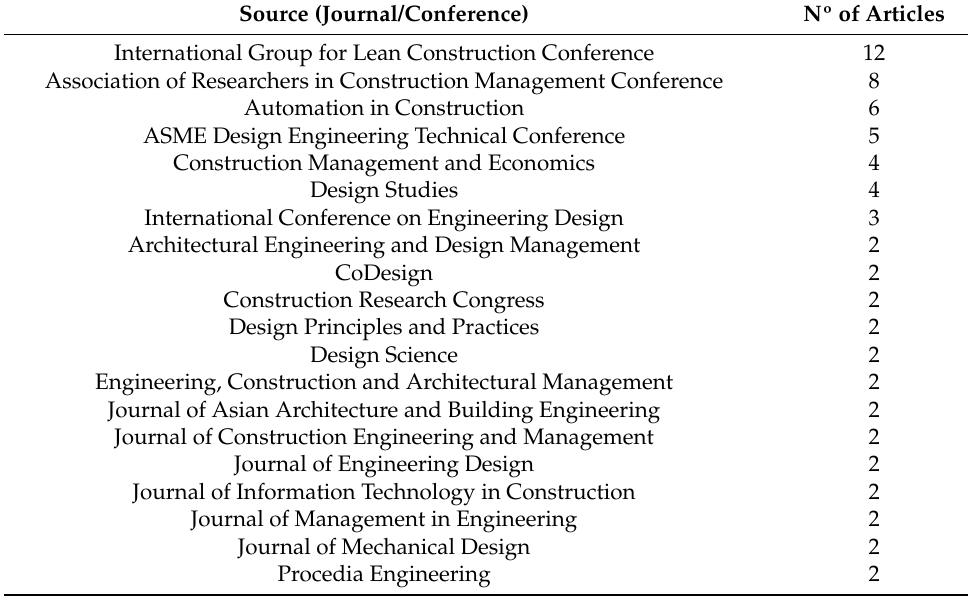
Figure 4. The density of the main researching countries according to the total number of selected publications. Table 2. Main academic sources identified with two or more